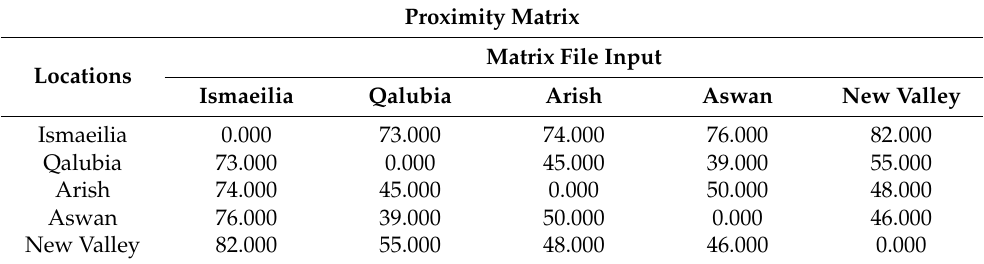
Figure 10. A schematic diagram showing the sites for collecting samples, indication of the methods used, and the most important results obtained. (A) OPA 13; (B) OPA14; (C) OPA16; (D) OPA19; (E) OPA 20. Table 7. Genetic distance values among populations R. ferrugineus from five